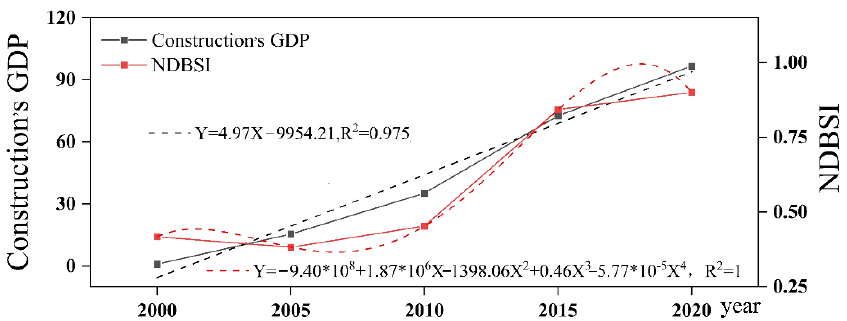
Figure 11. Statistical chart of GDP and NDBSI mean changes in the construction industry in the basin.